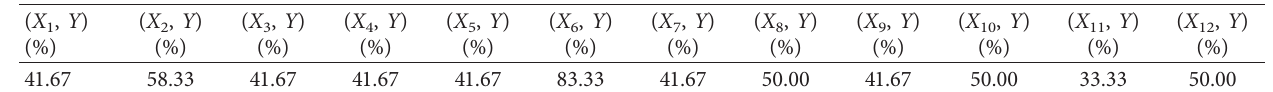
Figure 3: Case similarity analysis based on complex network, represented by the weighted all degree centrality. Table 7: Case similarity evaluation.